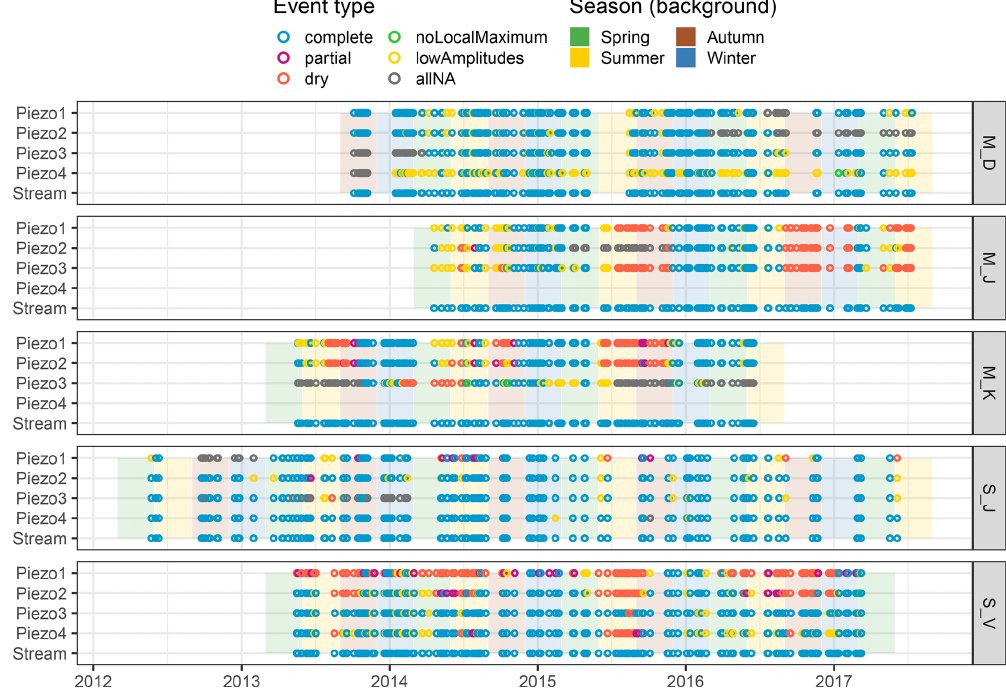
Figure 6. Spatio-temporal distribution of detected events for marls (M_) and schist (S_) between June 2012 and July 2017. Seasons are